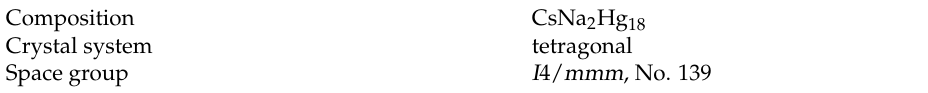
Table 2. Crystallographic data and details on single crystal data collection, structure solution, and refinement for CsNa 2 Hg 18 . Data collection was performed at room temperature. All standard deviations are given in parentheses in the units of the last